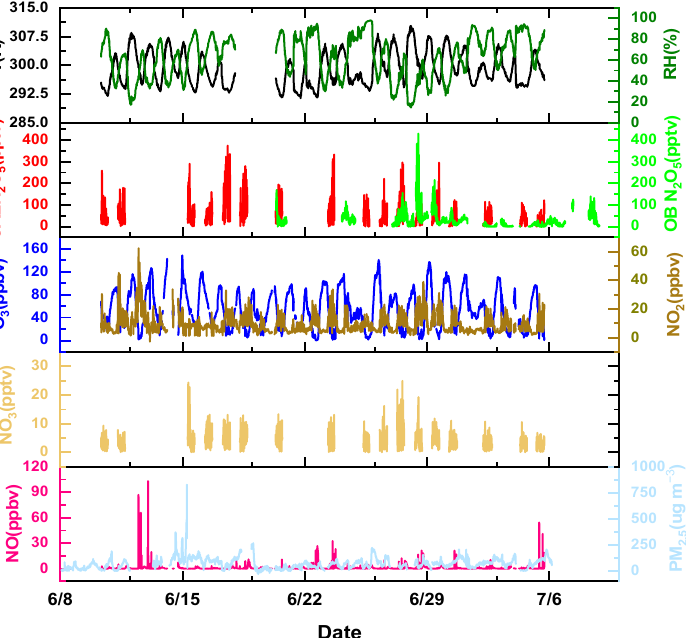
Figure 3. Time series of N 2 O 5 , NO 3 , and related trace gases. OB N 2 O 5 is the mixing ratio of N 2 O 5 observed by CIMS, and CAL N 2 O 5 is the mixing ratio of N 2 O 5 calculated by NO 3 and NO 2 .